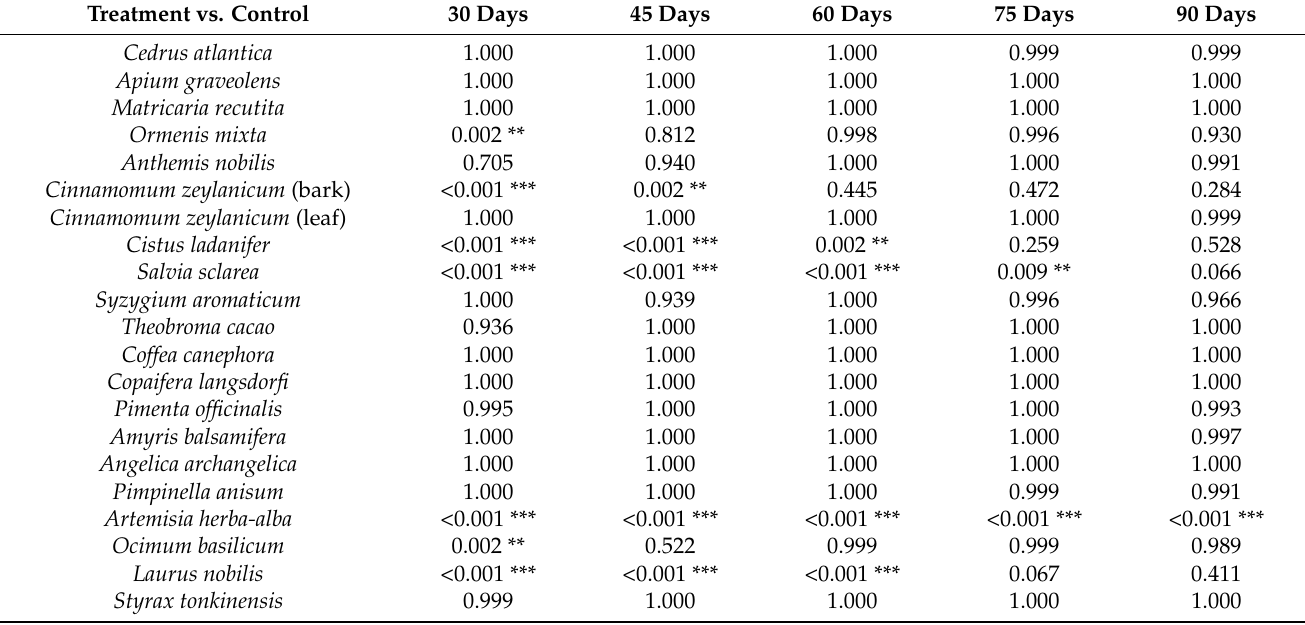
Table 1. Tukey’s test p -values describing the Eos’ effects on sprout length relative to the control at all time points.